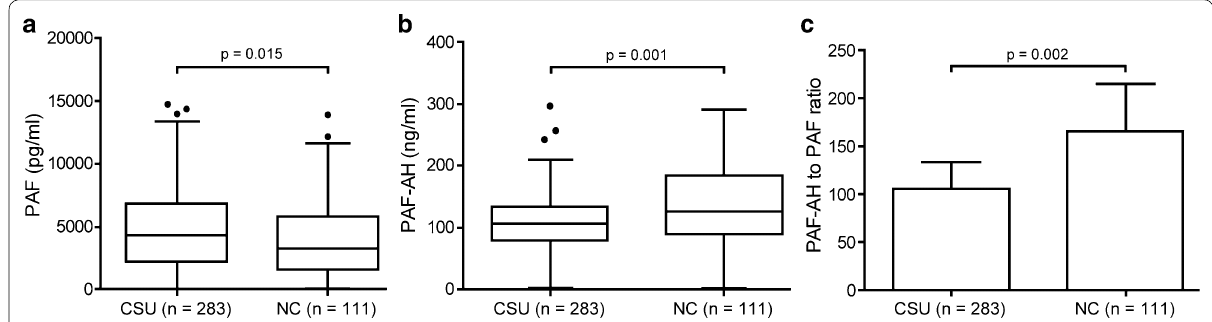
p values were obtained by Pearson’s Chi square test for categorical variables and Mann–Whitney U-test for continuous variables Medication score, daily mean loratadine dose to control symptoms